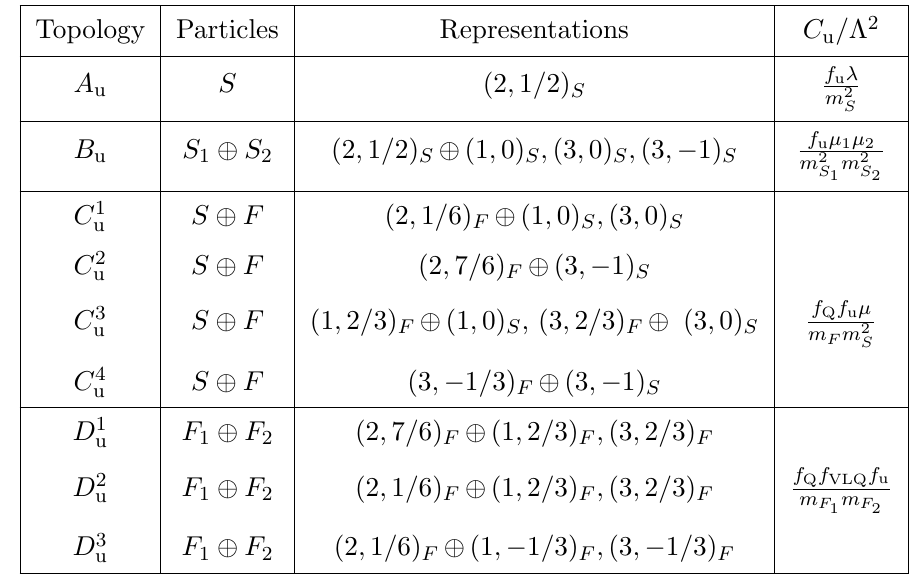
Table 1 . Tree-level topologies of the Yukawa operator for up-type quarks, see eq. (2.5). S stands for scalar, F for fermion, with the representation under (SU(2) L ; Y). All vector-like fermions are color triplets, while the scalars are color singlets.